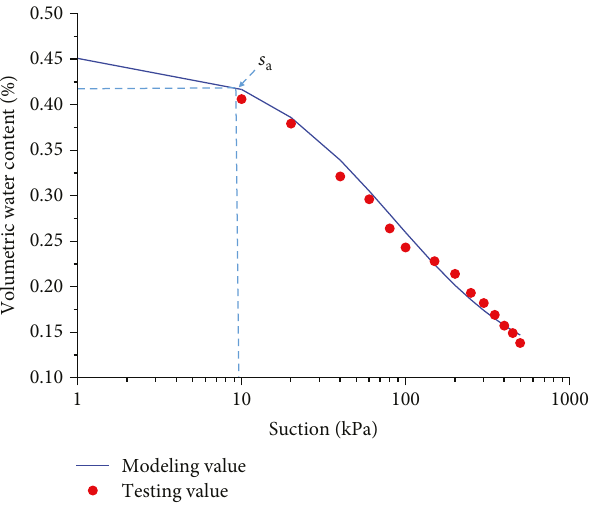
Figure 10: Result comparison at the void ratio of 0.7.